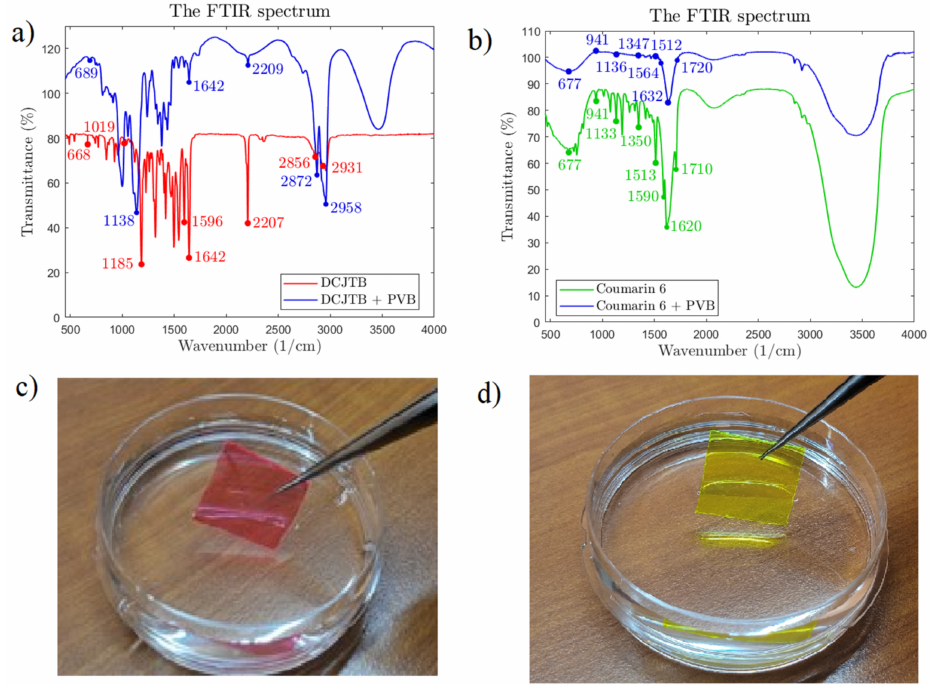
Figure 9. FTIR spectroscopy: ( a ) pure DCJTB and hybrid material, ( b ) pure coumarin-6 and hybrid material, ( c ) red hybrid material in water, and ( d ) green hybrid material in